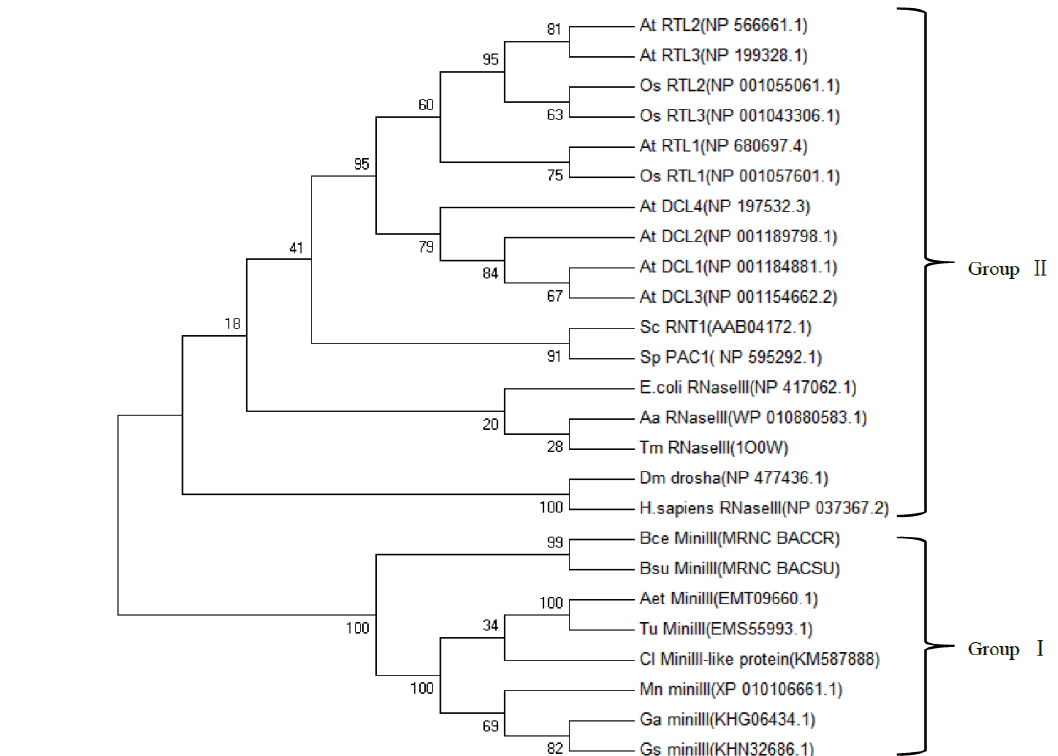
Figure 6. Phylogenetic tree of Cl RTL1 deduced protein with other numbers of the RNase III family. The phylogenetic tree was constructed using MEGA 6.0 with the